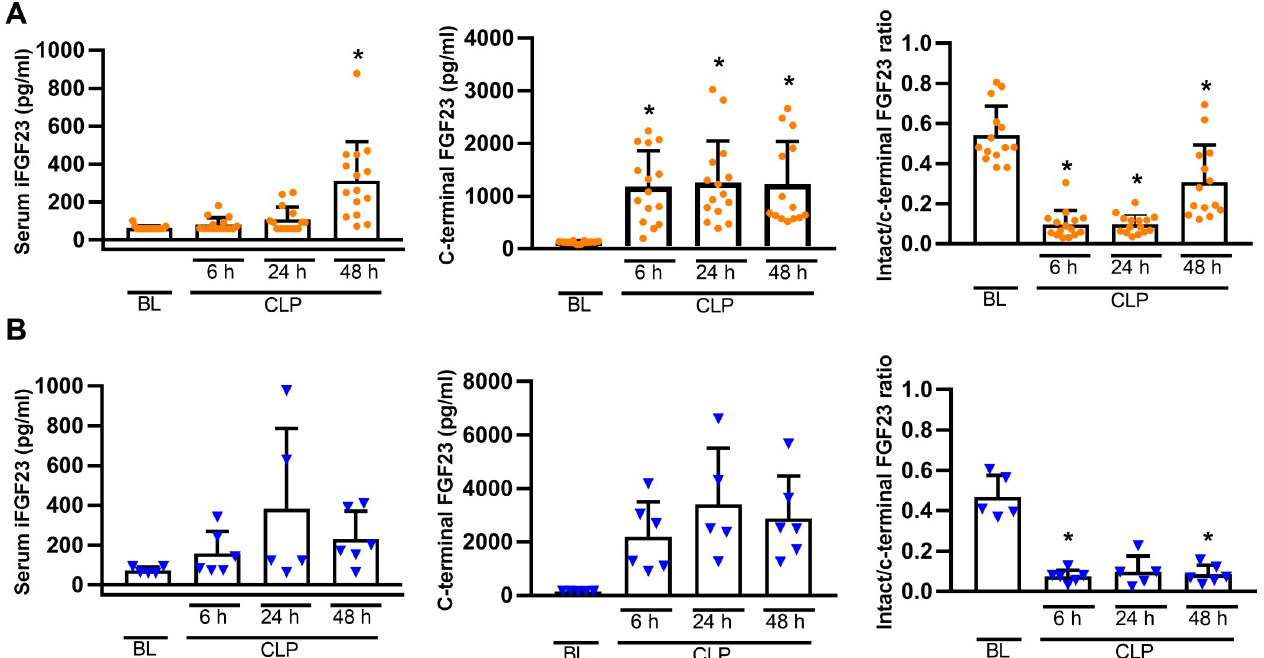
Fig 1. CLP-induced increase in plasma C-terminal and intact FGF23 levels. Plasma C-terminal and iFGF23 concentration in females (A) and males (B) increased post-CLP relative to baseline (BL; 24 h prior CLP). Each bar is the mean ± SD of 5–15 mice per group. Each symbol represents an individual sample. Mixed model approach with Geisser-Greenhouse correction, followed byTukey post hoc test . � , P < 0.05 vs. baseline within same sex. https://doi.org/10.1371/journal.pone.0251317.g001 abundance of FGF23 protein, we were unable to quantify splenic and hepatic FGF23 protein expression, using western blotting. Therefore, we measured splenic, hepatic and bone iFGF23 protein concentrations by ELISA (Fig 3).